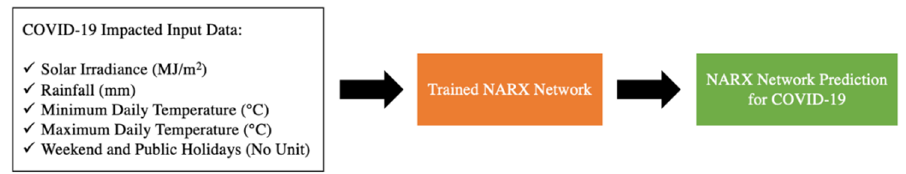
Figure 7. NARX Network prediction phase using COVID-19 impacted period.